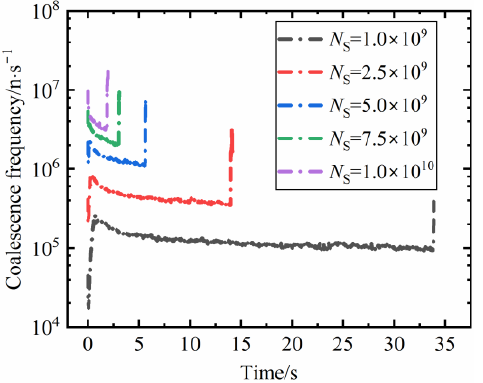
19 of 24 Figure 15. Change of contribution proportion of two growth modes to the maximum droplet size under different nucleus densities. 3.3.3. The Coalescence Frequency at Different Nucleus Densities The influence of coalescence growth behavior on the evolution process of dropwise condensation is also reflected in the coalescence frequency of surface droplet swarm. Figure 16 shows that, in the case of high condensation nucleus density, the coalescence frequency of droplet swarm on the condensation surface can reach the peak earlier, and its value is higher. As shown in Figure 17, the average coalescence frequency also has a higher level in the evolution process. This results in more coalescence growth behaviors of the maximum droplet on the condensation surface and eventually promotes the contri- bution proportion of coalescence growth to the largest droplet size. However, the size of growth of the maximum droplet is mainly derived from the coalescence growth, so the high density of the condensation nucleus contributes to the improvement of the evolution rate and accelerates the evolution process. These verify the conclusions arrived at in Section 3.3.2 and Section 3.2.1. In contrast, due to the influence